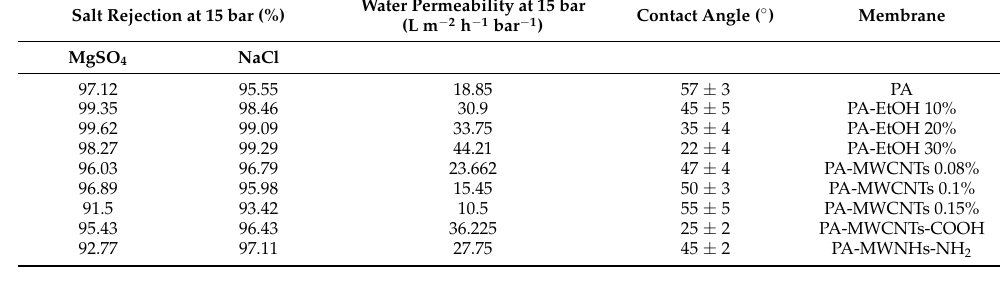
Table 1. Contact angle, water permeability, and salt rejection results of all membranes. Salt Rejection at 15 bar (%)